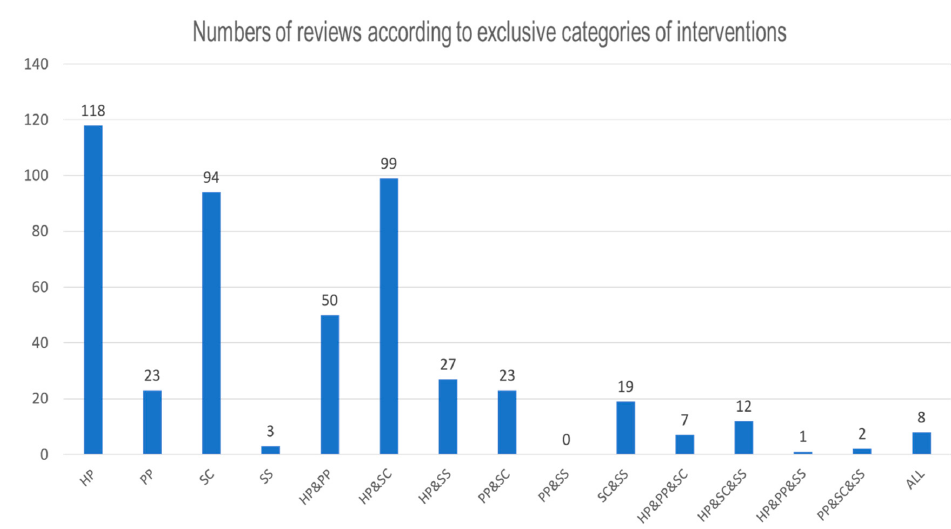
Figure 4. Number of reviews according to specific intervention categories.